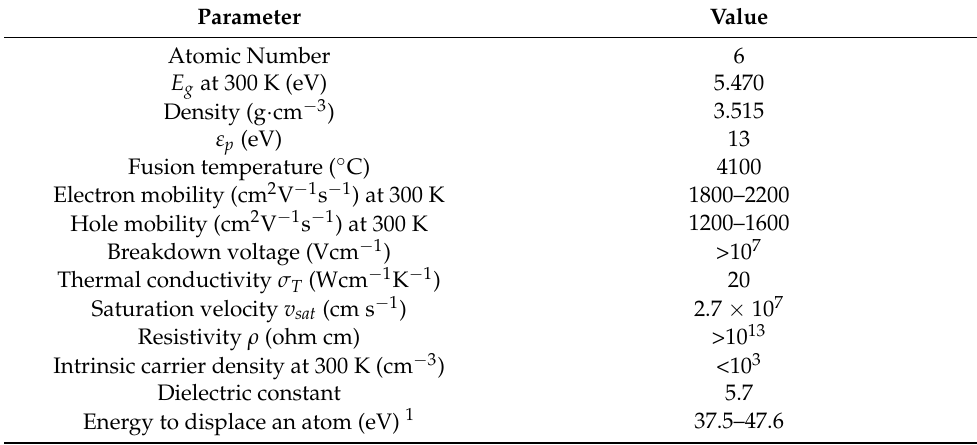
Table 1. Diamond parameters 1